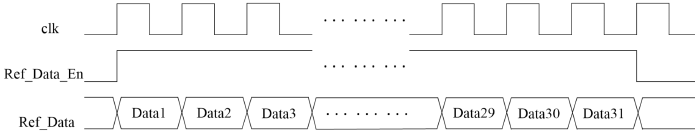
Figure 9. The timing of the reference sub-area data